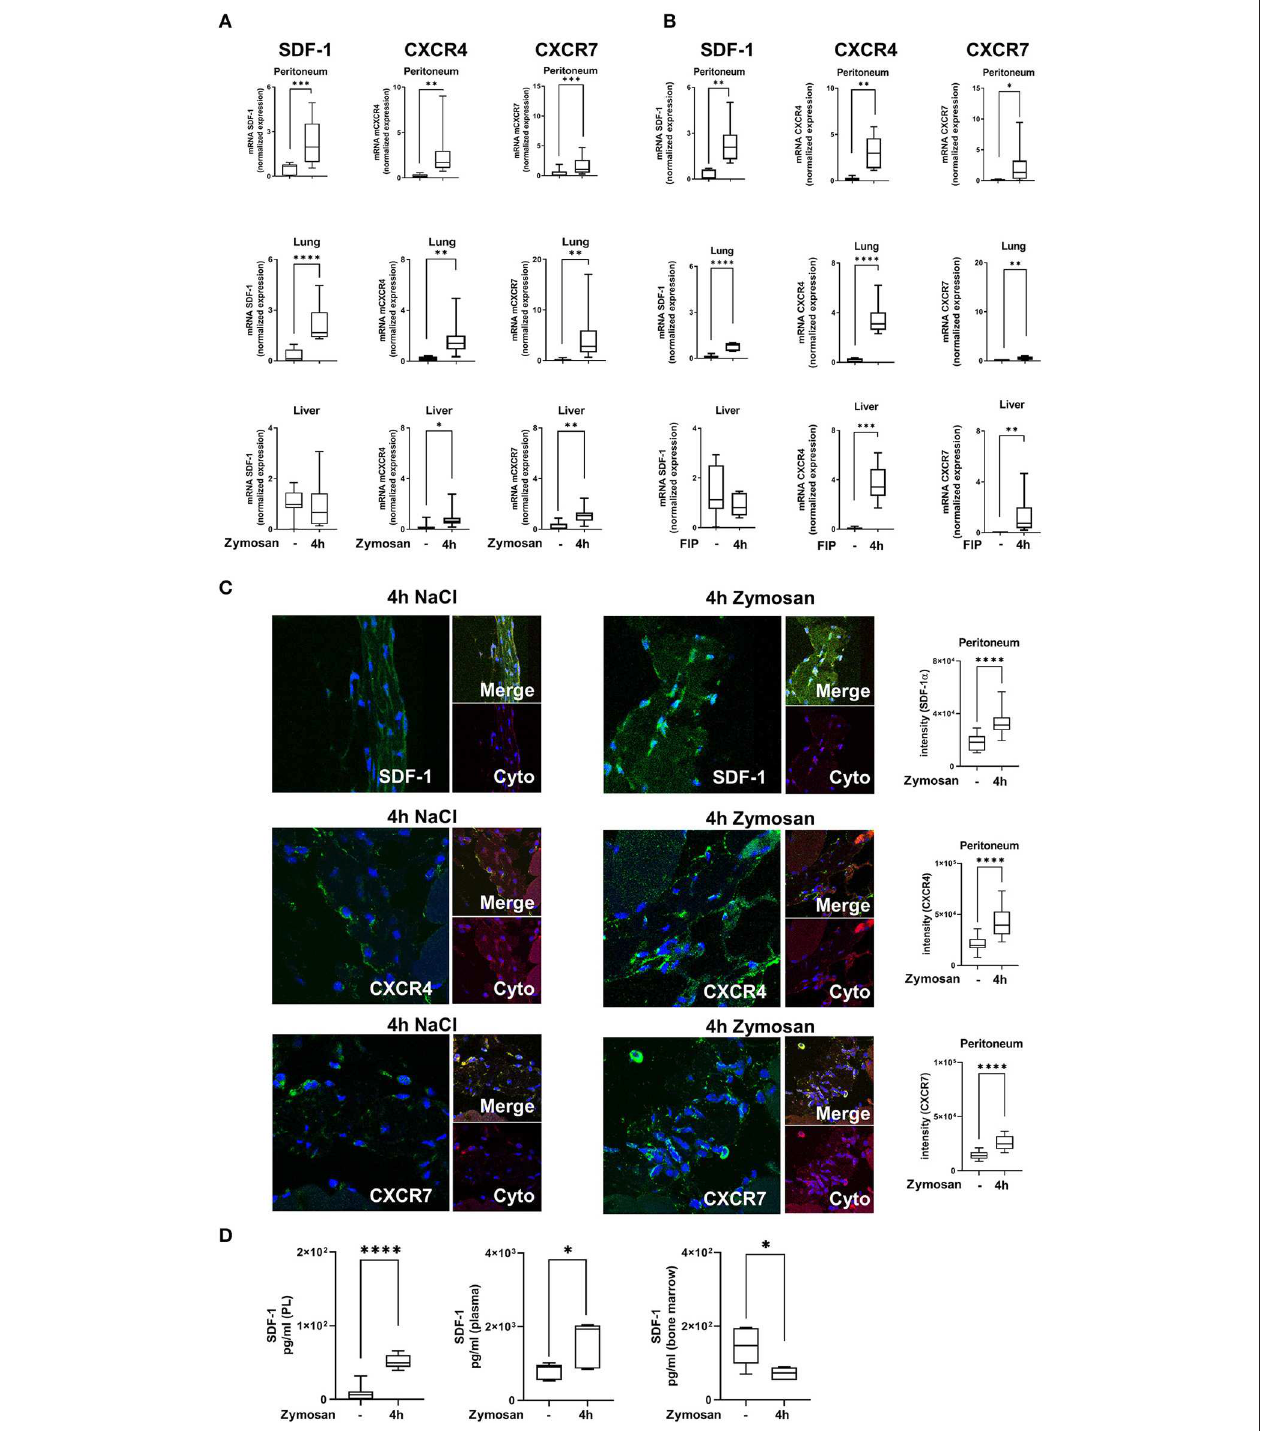
FIGURE 1 | Expression of stromal cell-derived factor-1 (SDF-1) and its receptors CXCR4 and CXCR7 in acute inflammation. (A) SDF-1, CXCR4, and CXCR7 mRNA levels were evaluated in peritoneal, lung and liver tissue 4h after zymosan ( n = 8–12) or (B) fecal administration ( n = 6–12). (C) Immunofluorescence detection of the expression of SDF-1, CXCR4, and CXCR7 (all green) in peritoneal tissue (Cyto; cytokeratin; red) 4h after zymosan (63x original magnification). Images are representatives of n = 3 experiments. Intensity was measured by ImageJ. (D) The release of SDF-1 α in the peritoneal cavity, in the plasma, and in the bone marrow of wild type mice was detected by using ELISA ( n = 6–12). Student’s t -test was used for statistical analysis. Data are presented as box and whisker graph with error bars indicating the range from minimum to maximum value; * p < 0.05; ** p < 0.01; *** p < 0.001; **** p < 0.0001.